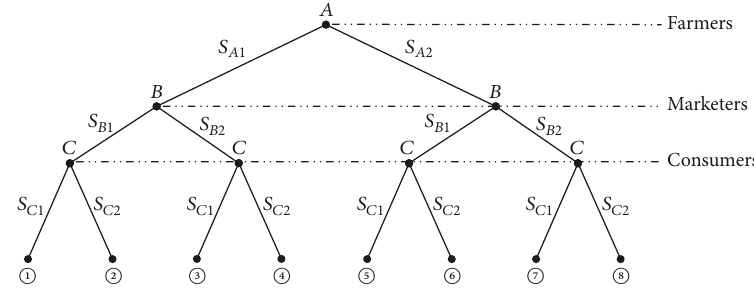
Figure 1: The game tree of agri-food